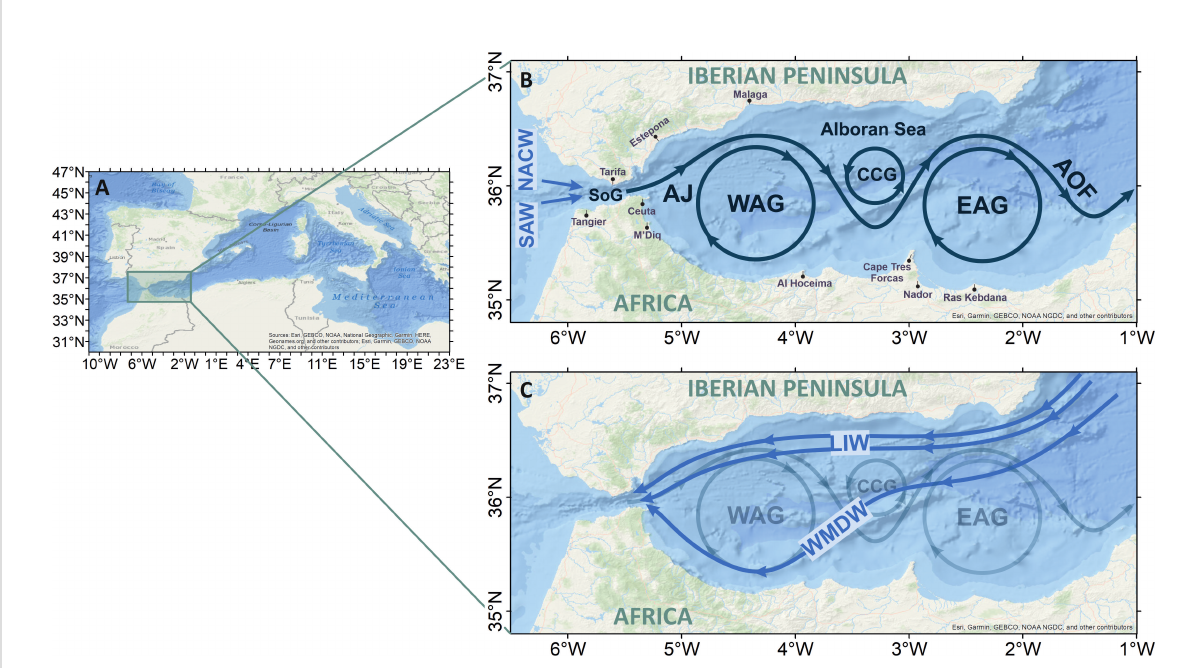
FIGURE 1 (A) Map of the Mediterranean Sea and central-eastern Atlantic Ocean showing the Alboran Sea location. (B) Map of Alboran Sea, tracing its general surface circulation: The Atlantic Jet (AJ), the western and eastern Alboran Gyres (WAG and EAG), the Central Cyclonic Gyre (CCG), and the Almeria-Oran front (AOF). (C) As panel (B) for the deep-pathways, sketching the mean circulation of LIW and WMDW (adapted from Kinder and Bryden,